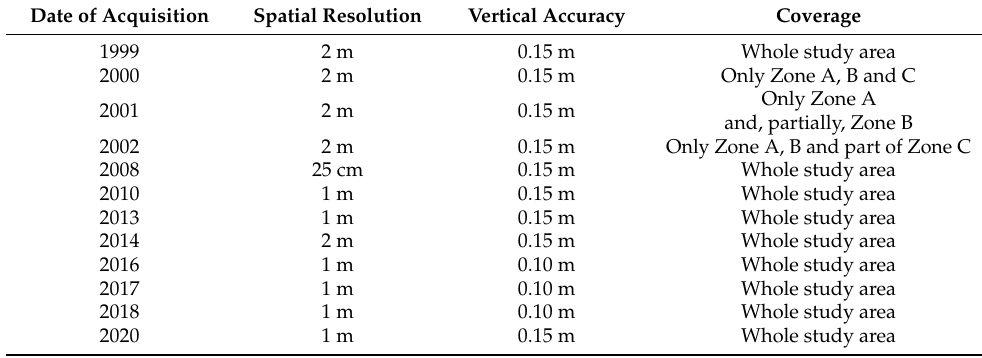
Table 1. Formby LiDAR